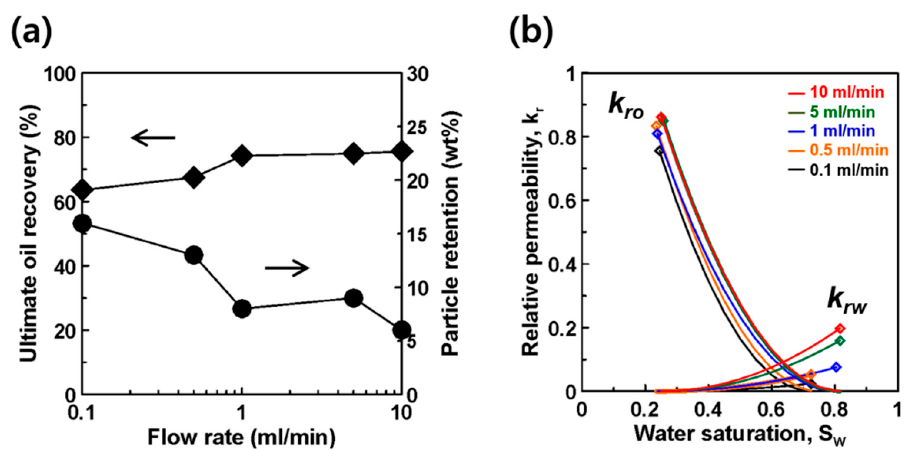
Figure 7. ( a ) Ultimate oil recovery and particle retention. ( b ) Relative permeability as a function of flow